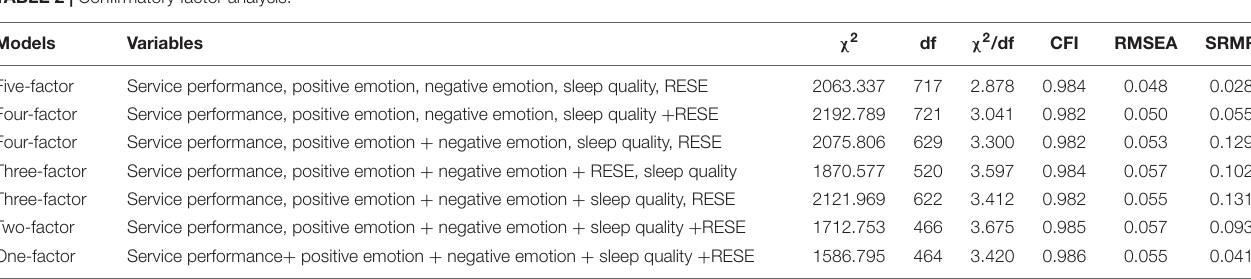
TABLE 2 | Confirmatory factor